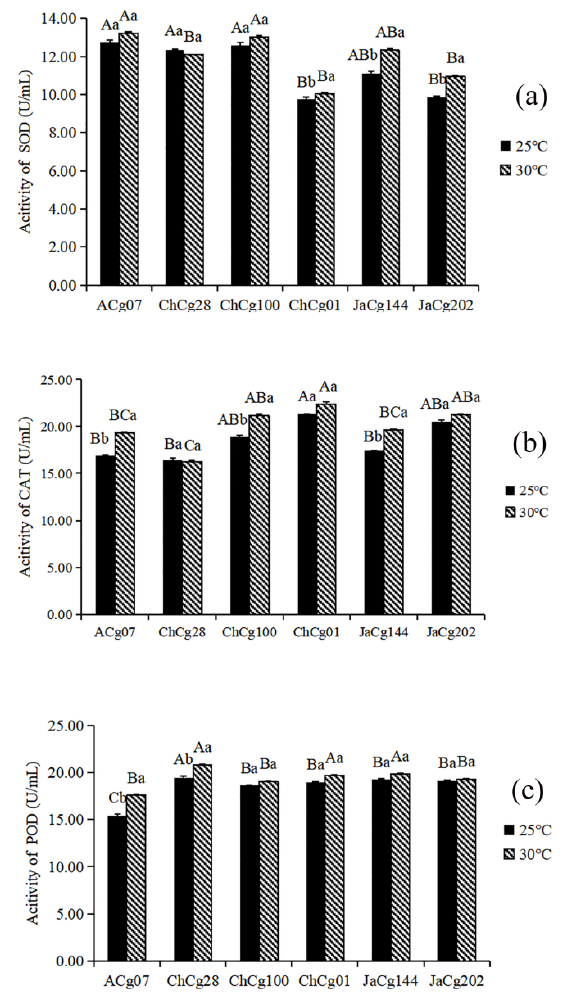
Figure 4. The antioxidant enzyme activities of six Cenococcum geophilum isolates under different temperatures. ( a ) SOD, ( b ) CAT and ( c ) POD. The data showed the mean ± SD for 25 ◦ C and 30 ◦ C replicates ( n = 3). Uppercase indicates the difference between different isolates at the same temperature (Kruskal–Wallis test, p < 0.05), lowercase indicates the difference between different temperatures of the same isolate (Student’s t test, p < 0.05).